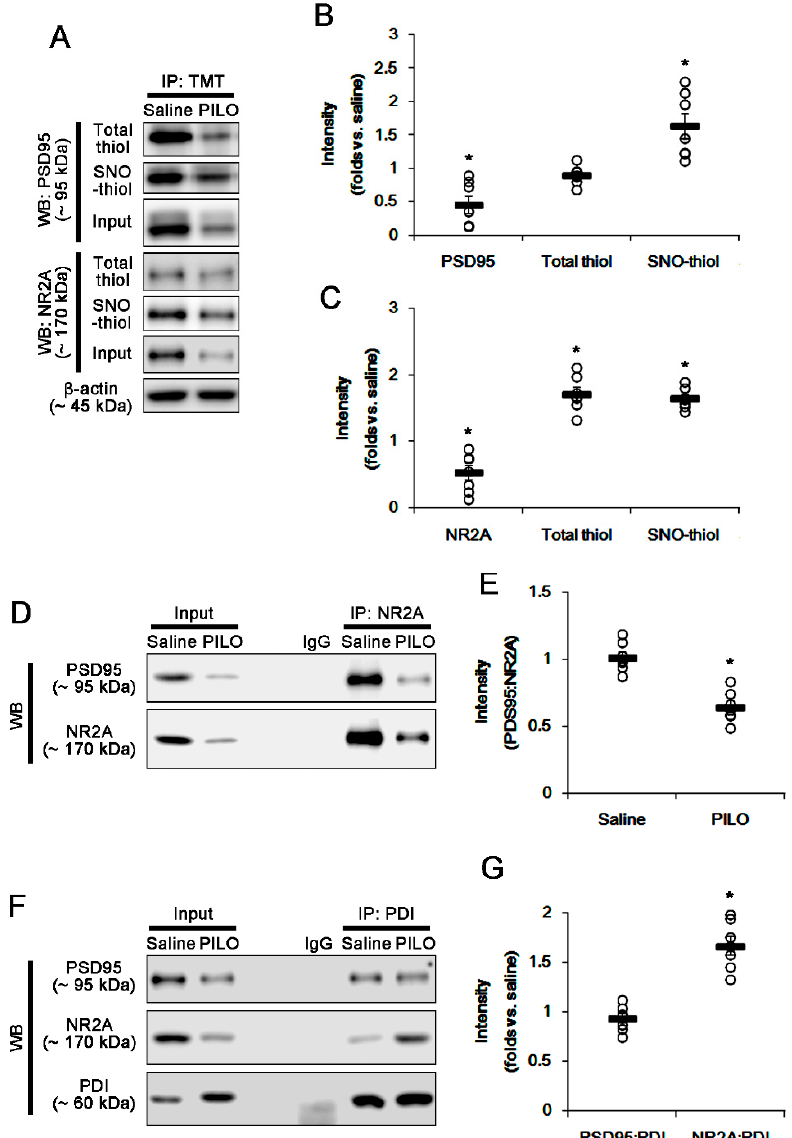
Figure 2. The effect of acute seizures on the total- and SNO-thiol levels on PSD95 and NR2A, and the bindings of NR2A–PSD95, PDI–PSD95 and PDI–NR2A in the hippocampus. ( A ) Representative Western blot for expression and the amounts of total- and SNO-thiols on PSD95 and NR2A. Acute seizures increase the number of SNO-thiols, but not total thiols, on PSD95. ( B , C ) Quantification of Western blot data. Open circles indicate each individual value. Horizontal bars indicate mean value. Error bars indicate SEM (* p < 0.05 vs. saline, Student’s t -test, n = 7, respectively). ( D ) Co-immunoprecipitation analysis of NR2A–PSD95 interaction following acute seizures. Acute seizure reduces both PSD95 and NR2A expression. However, the NR2A–PSD95 bindings are significantly reduced, as compared to saline-treated animals. ( E ) Quantification of Western blot data. Open circles indicate each individual value. Horizontal bars indicate mean value. Error bars indicate SEM (* p < 0.05 vs. saline, Student’s t -test, n = 7, respectively). ( F ) Co-immunoprecipitation analyses of PDI interactions with PSD95 and NR2A. Acute seizure increases PDI expression and PDI–NR2A binding, without altering PDI–PSD95 binding. ( G ) Quantification of Western blot data. Open circles indicate each individual value. Horizontal bars indicate mean value. Error bars indicate SEM (* p < 0.05 vs. saline, Student’s t -test, n = 7, respectively).